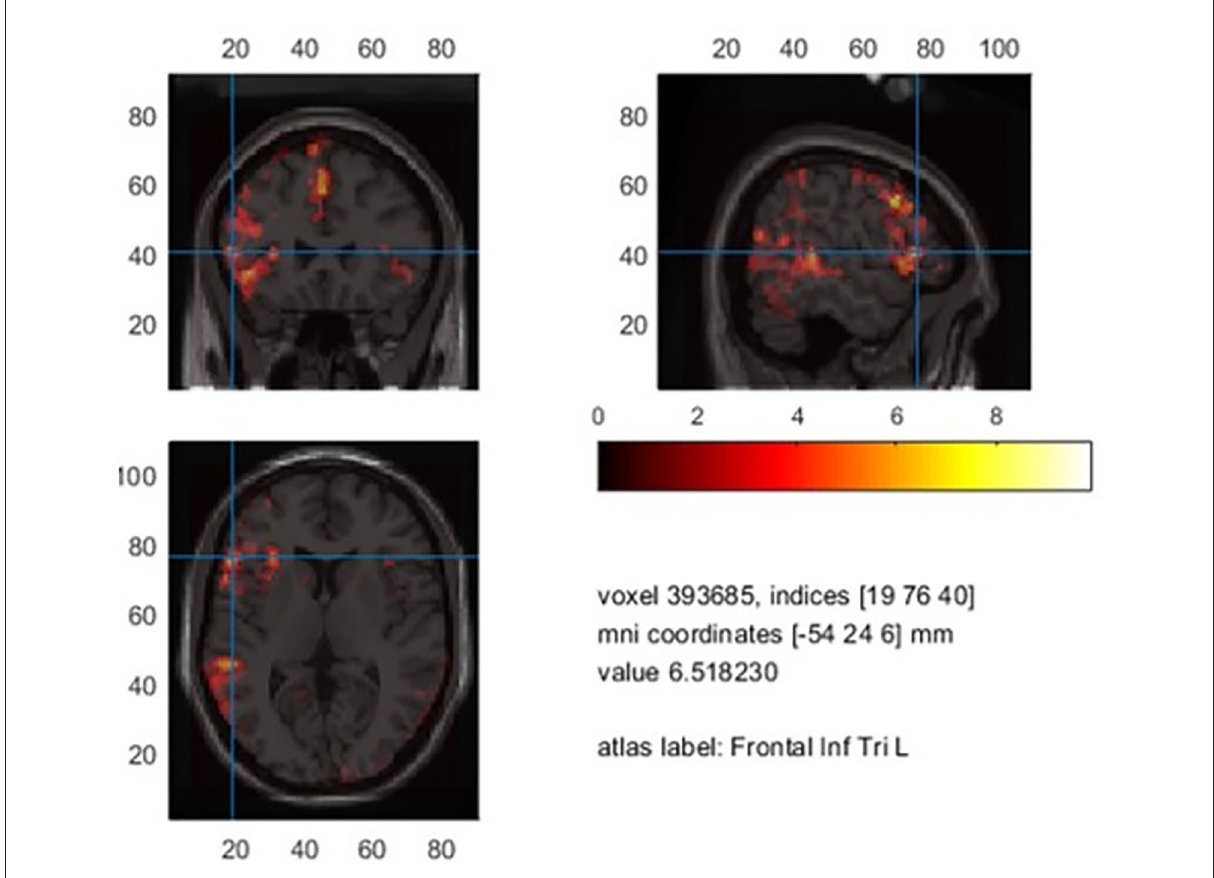
FIGURE5 Mean significant t -values in controls.